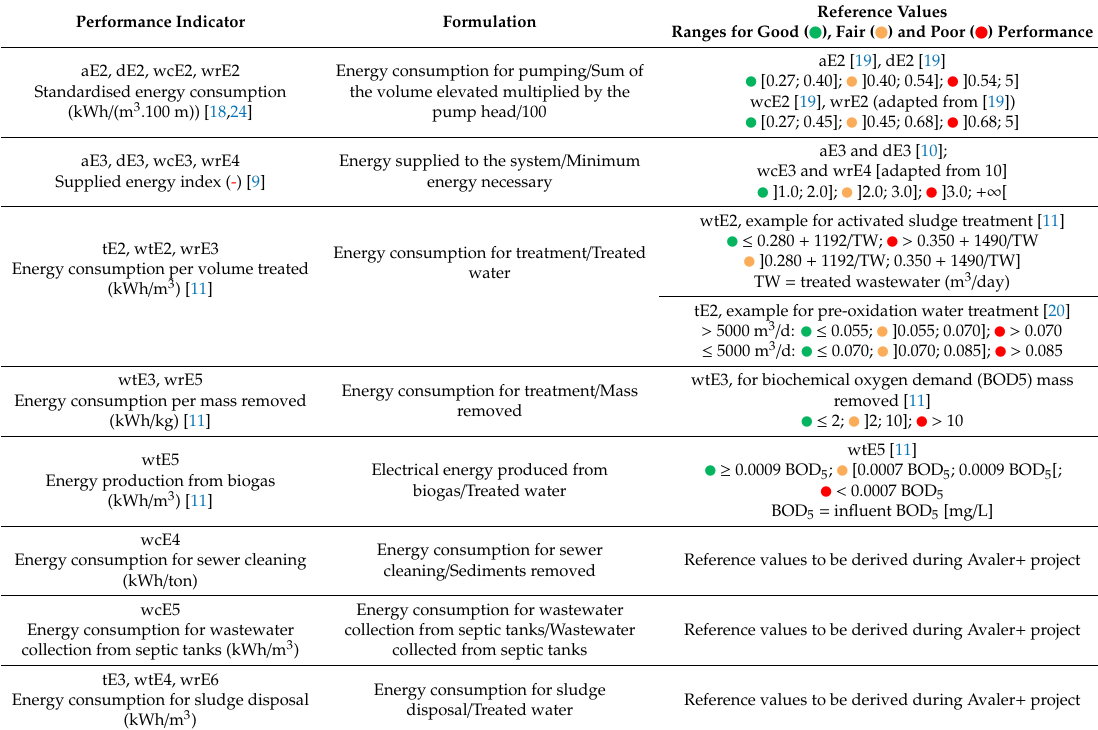
Table 2. Performance indicators for energy e ffi ciency assessment, formulation and reference